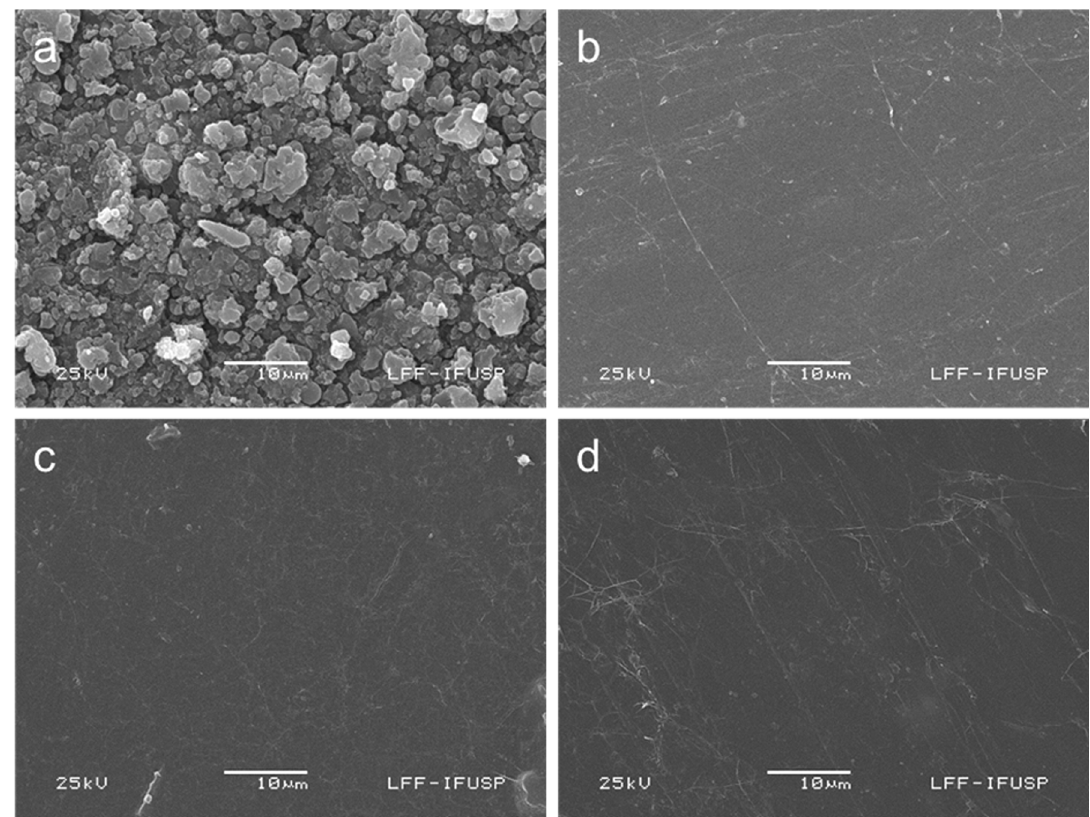
Figure 4. Micrographs showing (a) irregular colloidal shape of AC_KL and fractured surfaces of (b) PP, (c) PP_AC_2 and (d)